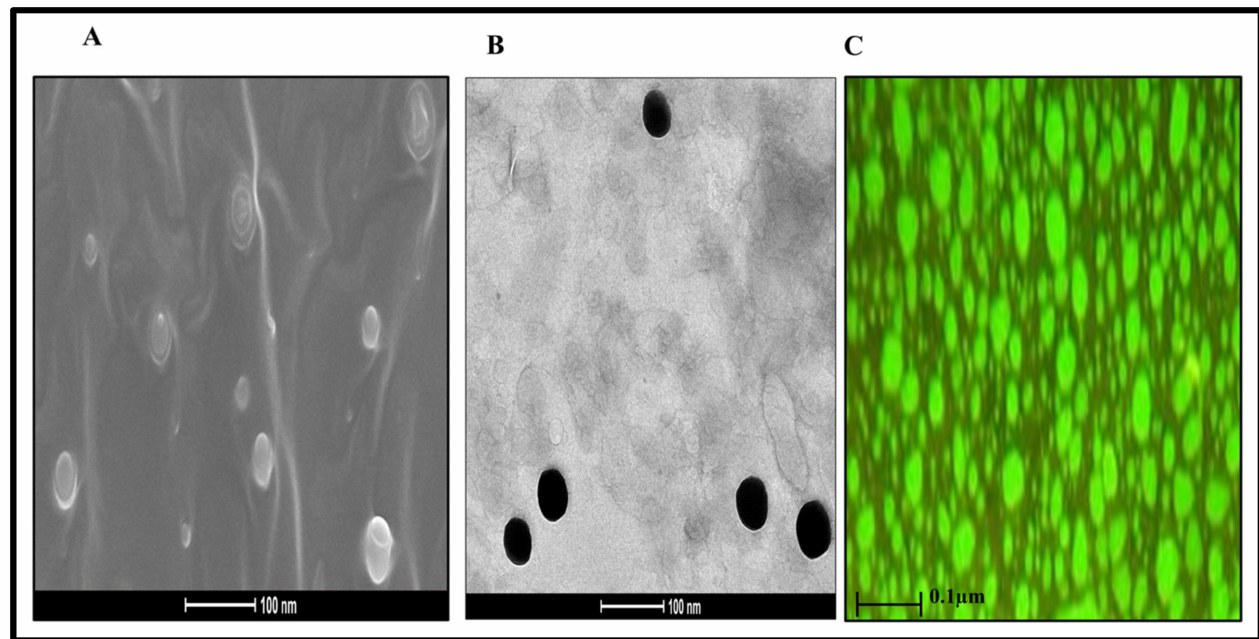
Figure 9. ( A ) SEM, ( B ) TEM, and ( C ) fluorescent microscopy of the optimized